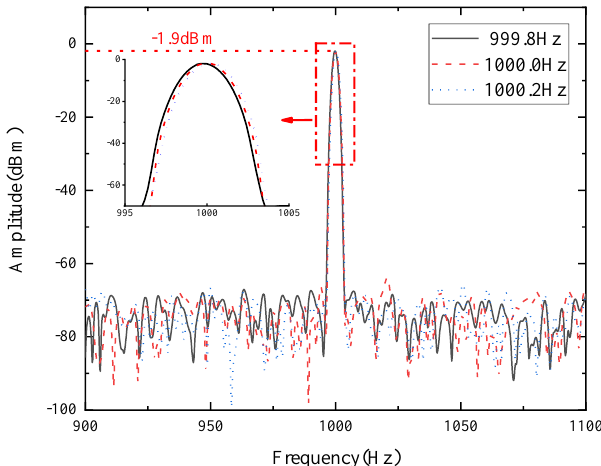
Figure 8. Sensing resolution of the FFT-processed frequency spectrum at the center frequency of 1000.0 Hz with a shift of 0.2 Hz. 1000.0 Hz with a shift of 0.2